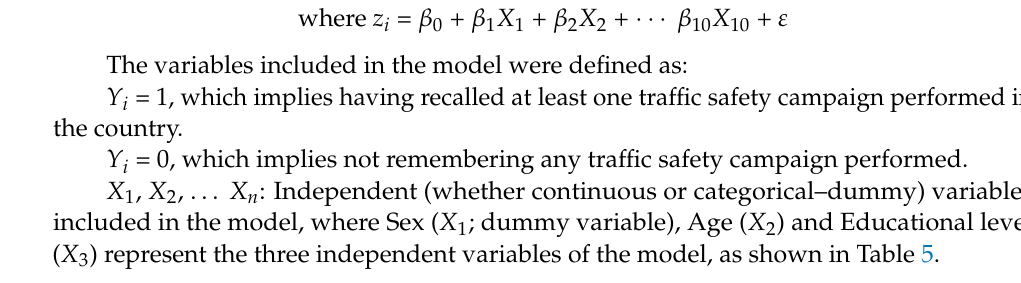
Table 5. Logistic Regression Model (Logit). Dependent variable: Having remember at least one traffic safety campaign. Variables in the Equation B S.E. c Wald